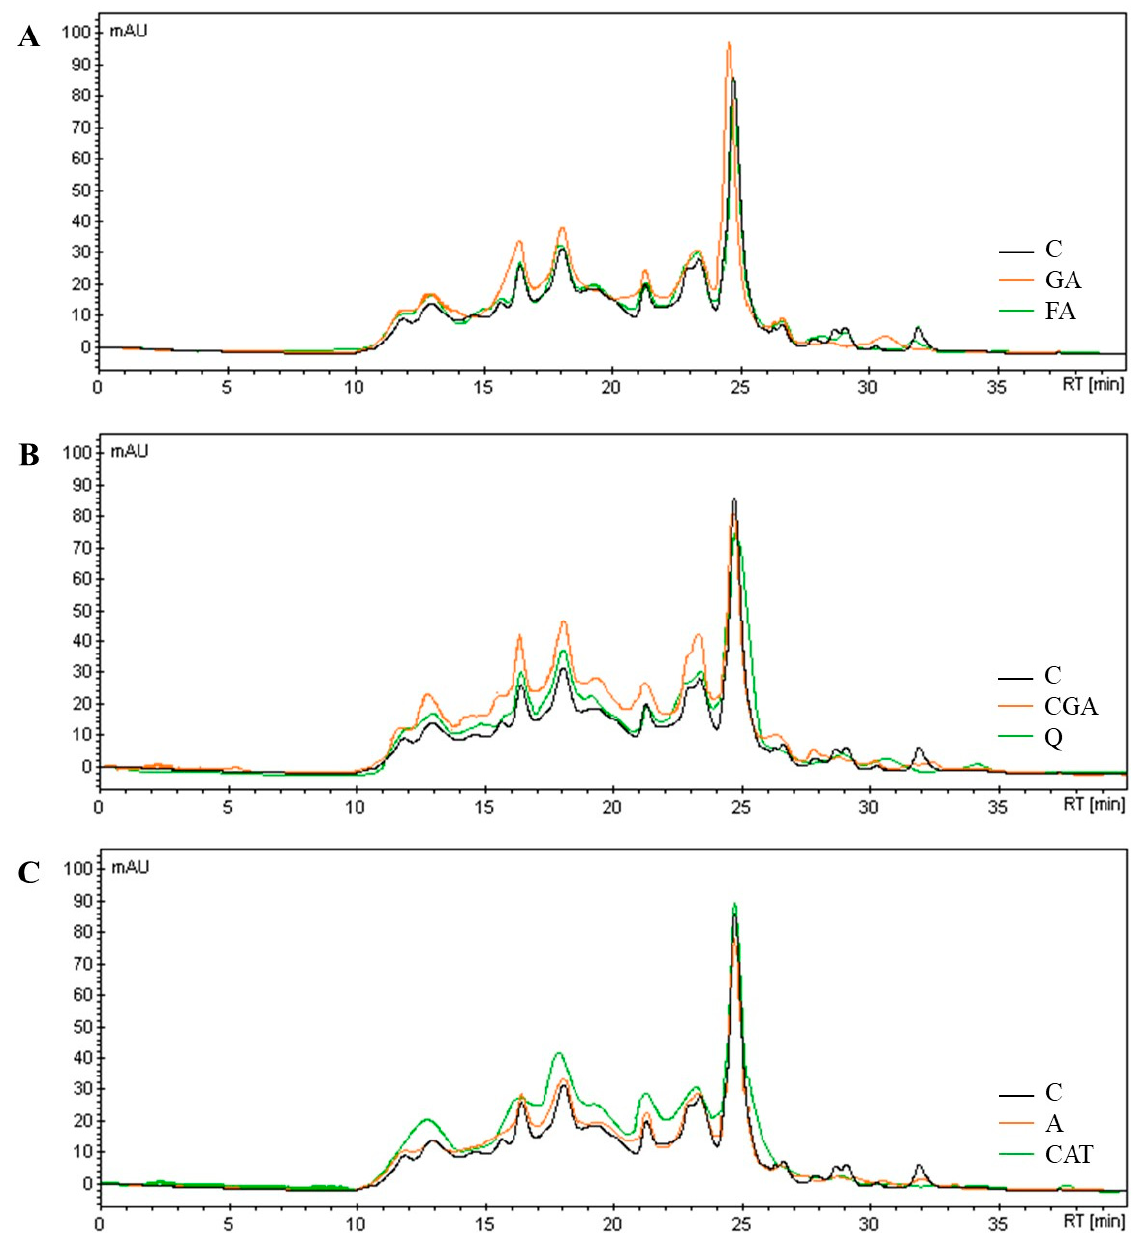
Figure 2. Effect of phenolic addition on SE–HPLC profile of white bean proteins. Abbreviations: C—control, GA—gallic acid, FA—ferulic acid, GGA—chlorogenic acid, Q—quercetin, A—apigenin, CAT—catechin; RT—retention time.